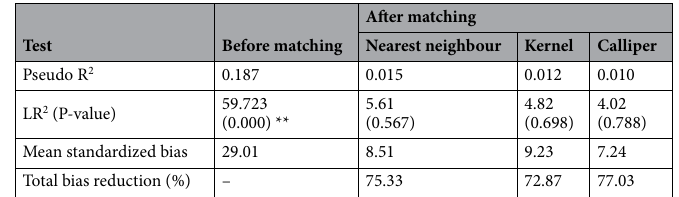
Table 12. Summary of model for balancing test of neem coated urea. Source: Authors’ estimates using field survey data. *Denotes significance level at 1%.